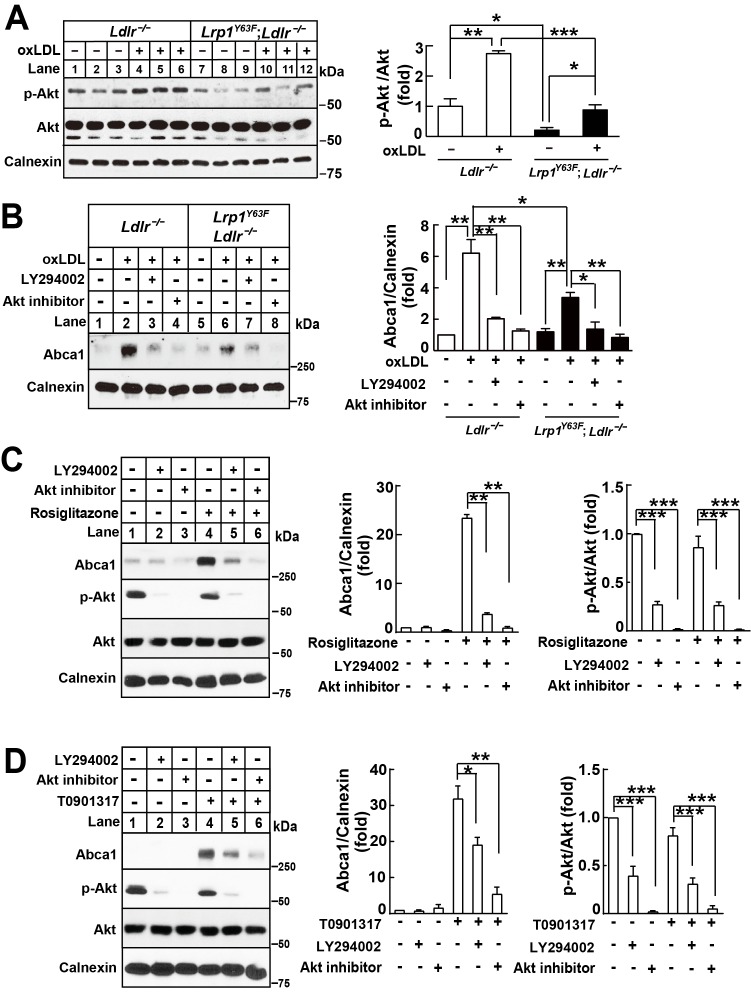
Lrp1Y63F-induced impairment of Abca1 up-regulation is dependent on PI3K/Akt activities.(A) Western blot analysis of Akt phosphorylation in macrophages treated with or without ox-LDL. (B) Isolated peritoneal macrophages from Lrp1Y63F;Ldlr−/− and Ldlr−/− were pre-incubated with LY294002 (PI3K antagonist, 10 μM) or Akt inhibitor (10 μM) for 1 hr, followed by ox-LDL treatment for an additional 24 hr. Abca1 protein levels were analyzed by Western blot analysis (left) and quantification is shown (right). (C–D) Macrophages were pretreated with LY294002 (10 μM) or Akt inhibitor (10 μM) for 1 hr, followed by the application of 10 μM rosiglitizone (C) or 10 μM T0901317 (D) for an additional 24 hr. Abca1 and pAkt expression were assessed by immunoblot analysis (left) and quantification is shown (right). Data are mean ±SEM from three independent experiments. *p<0.05; **p<0.01; ***p<0.001.